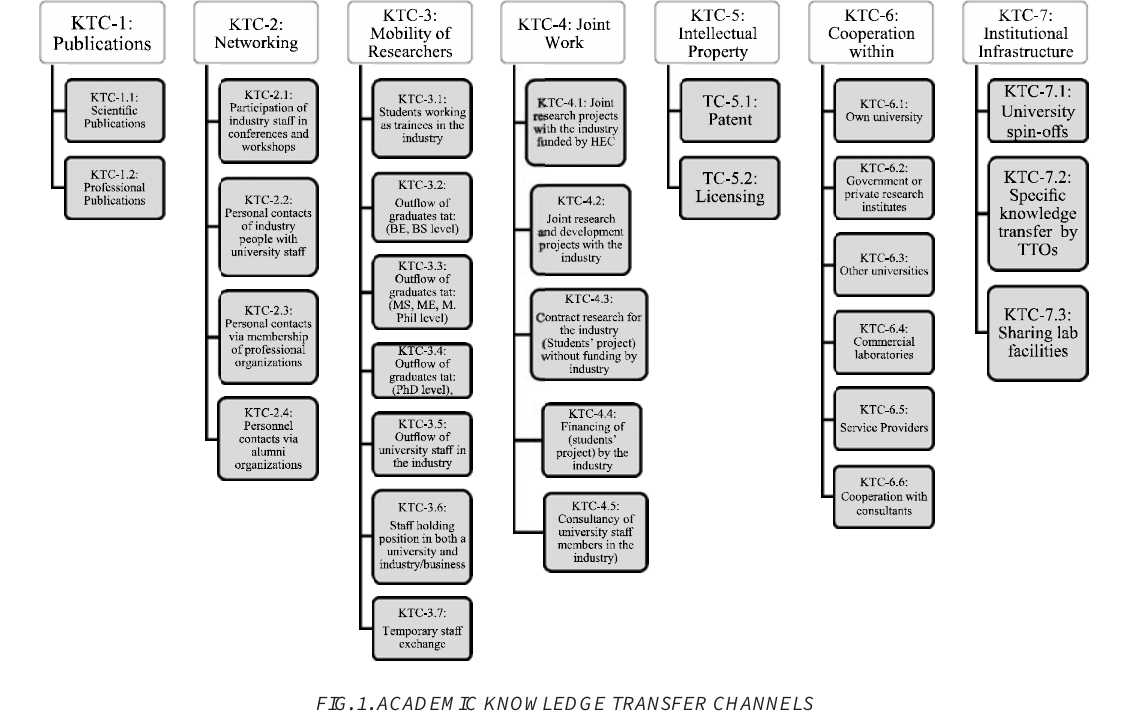
FIG. 1. ACADEMIC KNOWLEDGE TRANSFER